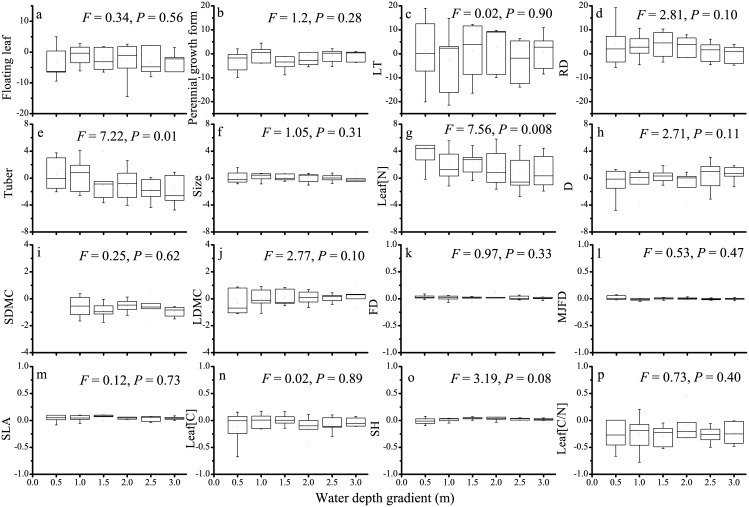
Boxplots showing the differences in λ-values derived the maxent models along water depth gradient for the 16 measured traits of macrophyte species.The F and P values from linear regression analyses are shown. LT: lamina thickness; RD: rooting depth; Leaf [N]: leaf nitrogen content; D: stem diameter; SDMC: stem dry mass content; LDMC: leaf dry mass content; FD: flowering duration; MJFD: mean Julian flowering date; SLA: specific leaf area; Leaf [C]: leaf carbon content; SH: shoot height; Leaf [C/N]: leaf carbon/nitrogen ratio.